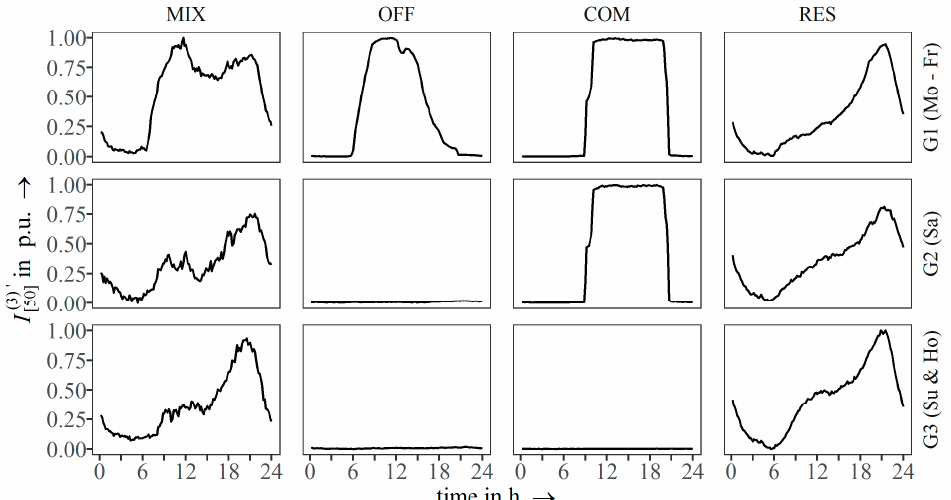
Figure 4. Example for typical emission profiles of the 3rd harmonic order for different consumer configurations: residential (RES), commercial (COM), office (OFF), and mixed (MIX) areas; min-max scaled 50th percentile time series for different day types: working days (G1), Saturdays (G2), and Sundays/holidays (G3); phase L1; aggregation interval: 10 min.